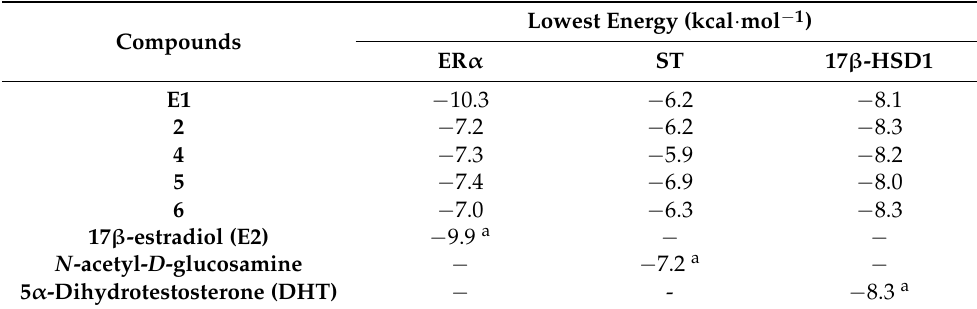
Table 3. Predicted affinity energies of compounds E1 , 2 , 4 – 6 calculated from molecular docking against known protein targets of steroidal molecules (ER α , ST, and 17 β -HSD1) a . Lowest Energy (kcal · mol − 1 ) Compounds ER α ST 17 β -HSD1